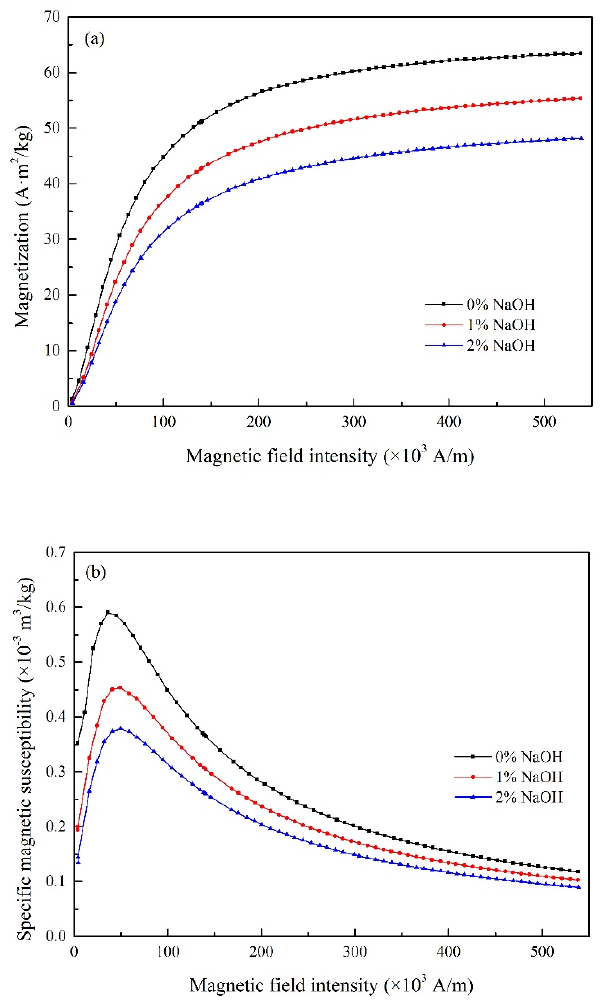
Figure 5. Magnetic intensity ( a ) and magnetic susceptibility ( b ) of reduction products with different NaOH contents at 560 °C.